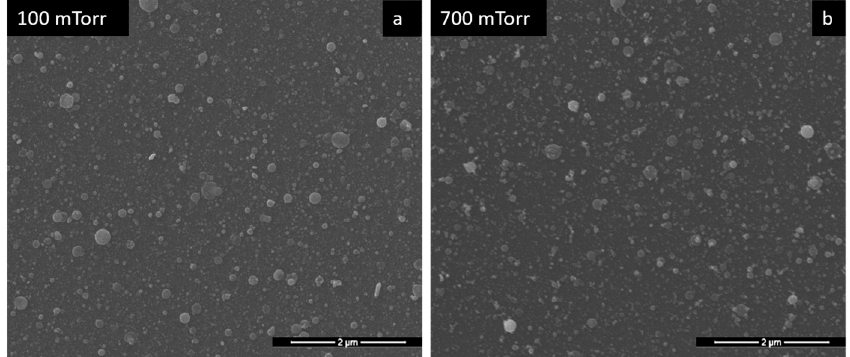
Figure 4. SEM images of Pd films at different gas pressures.